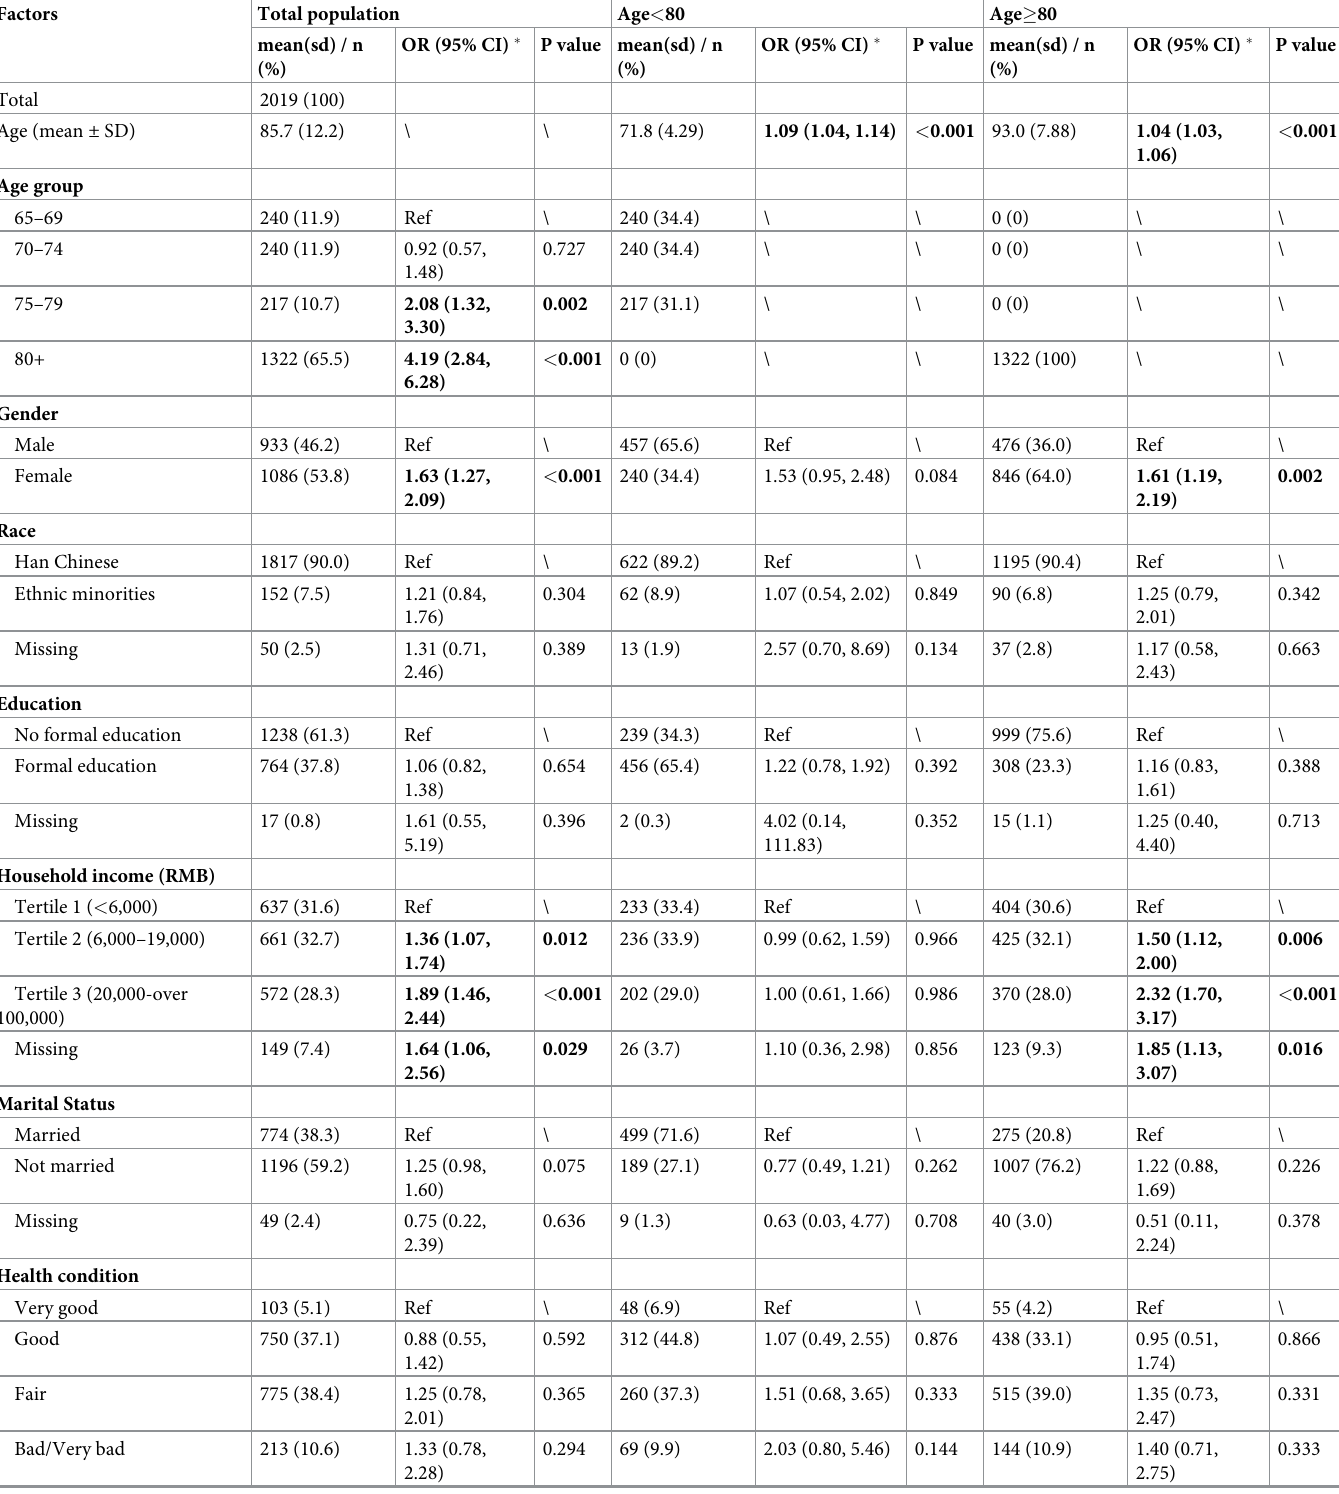
Table 3. Odds ratio (95% CI) of factors associated with CKD in Chinese participants (CLHLS